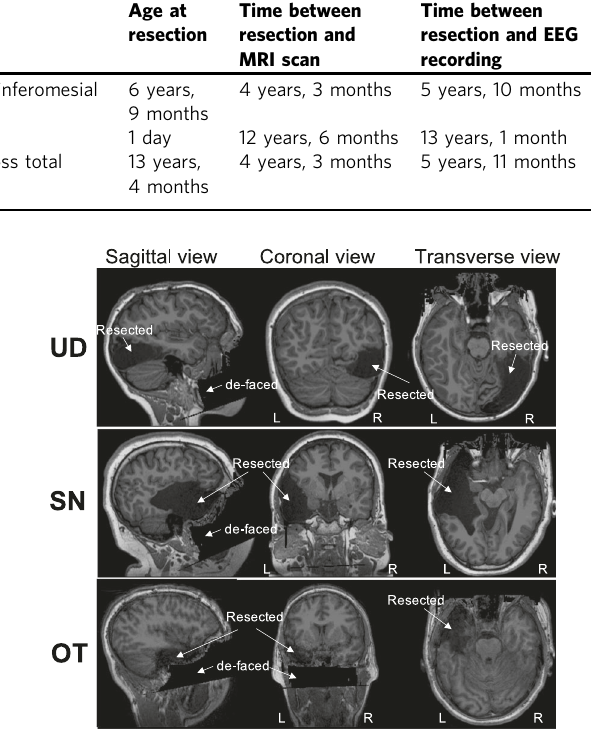
Fig. 2 Structural MRI scans of the three participants in the real dataset. UD with right occipitotemporal lobectomy, SN and OT with left temporal lobectomy (resected regions are highlighted with arrows). We have stripped away facial features to ensure anonymity of participants (de-faced regions are highlighted with